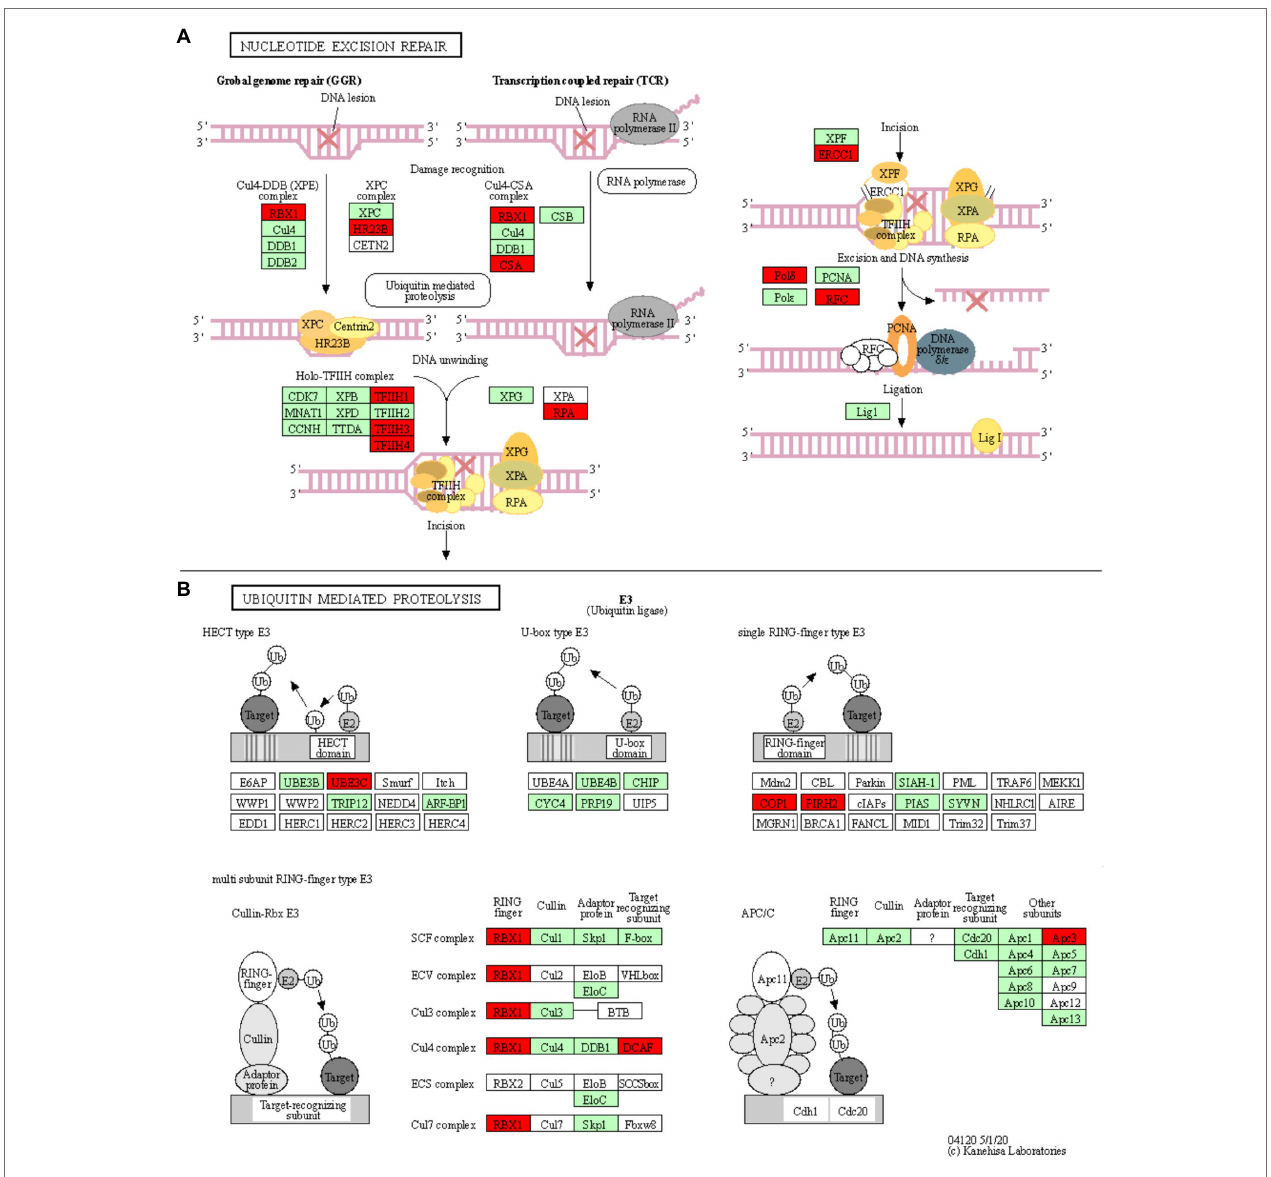
FIGURE 4 | Nucleotide excision repair and ubiquitin mediated proteolysis KEGG pathways. KOBAS was used to illustrate the enrichment of genes that are downregulated in Thatcher upon leaf rust infection. (A) Osa03420 (enrichment corrected value of p 5.61E-07). Note that, we found four additional KEGG enriched pathways that are involved in the DNA damage repair system: osa03022, osa03430, osa03030, and osa03440 (see Table 1 ). In total, these five pathways contain 18 unique downregulated genes. (B) Osa04120 (enrichment corrected value of p 1.02E-02). Note that most of down-regulated genes are E3 ubiquitin ligases. In total, this pathway contains 11 unique downregulated genes. Red boxes: genes that were downregulated; light green boxes: O. sativa genes that have been previously identified; and white boxes: genes that belong to the KEGG pathway but have no currently identified O. sativa